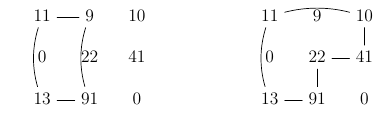
Figure 1. Five Stable Matchings (Matching C is Median-Stable) 4